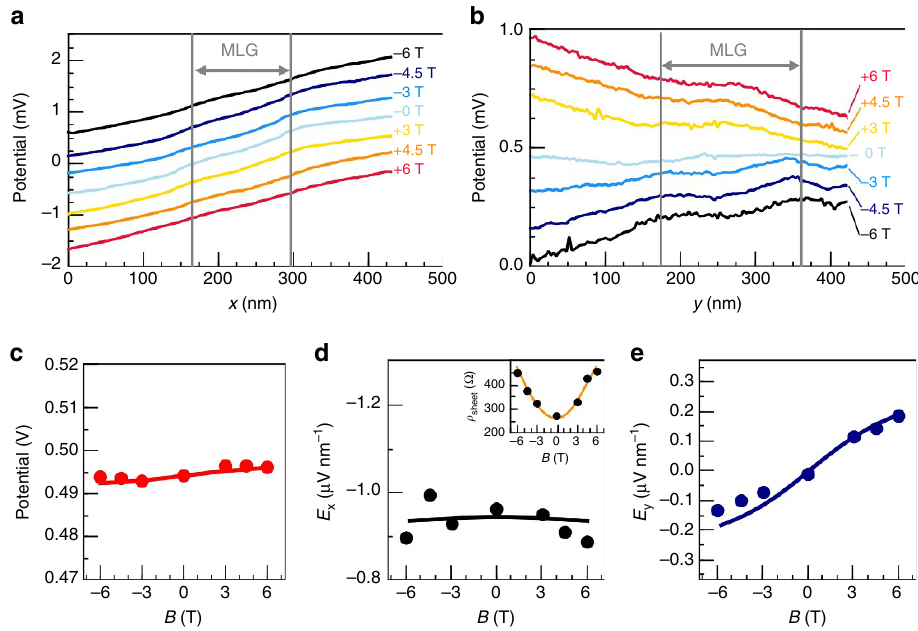
Figure 2 | Hall measurements on the atomic scale. ( a ) Potential across the sample region shown in Fig. 1c in x direction (averaged in y direction) and ( b ) in y direction (averaged in x direction). Lines have been shifted relative to each other. ( c ) Average potential as a function of magnetic field. ( d , e ) Electric field components E x and E y as a function of magnetic field B derived by linear fits from the data in a , b . The lines are the results of the macroscopic finite-element simulation as shown in Fig. 1d at the precise position of the measurement (see Supplementary Note 3 and Supplementary Fig. 5). For comparison, the experimental electric fields are normalized to V Trans ¼ 1V. The inset shows E x / j x with the macroscopic sheet resistance (yellow, taken from Fig. 1b).